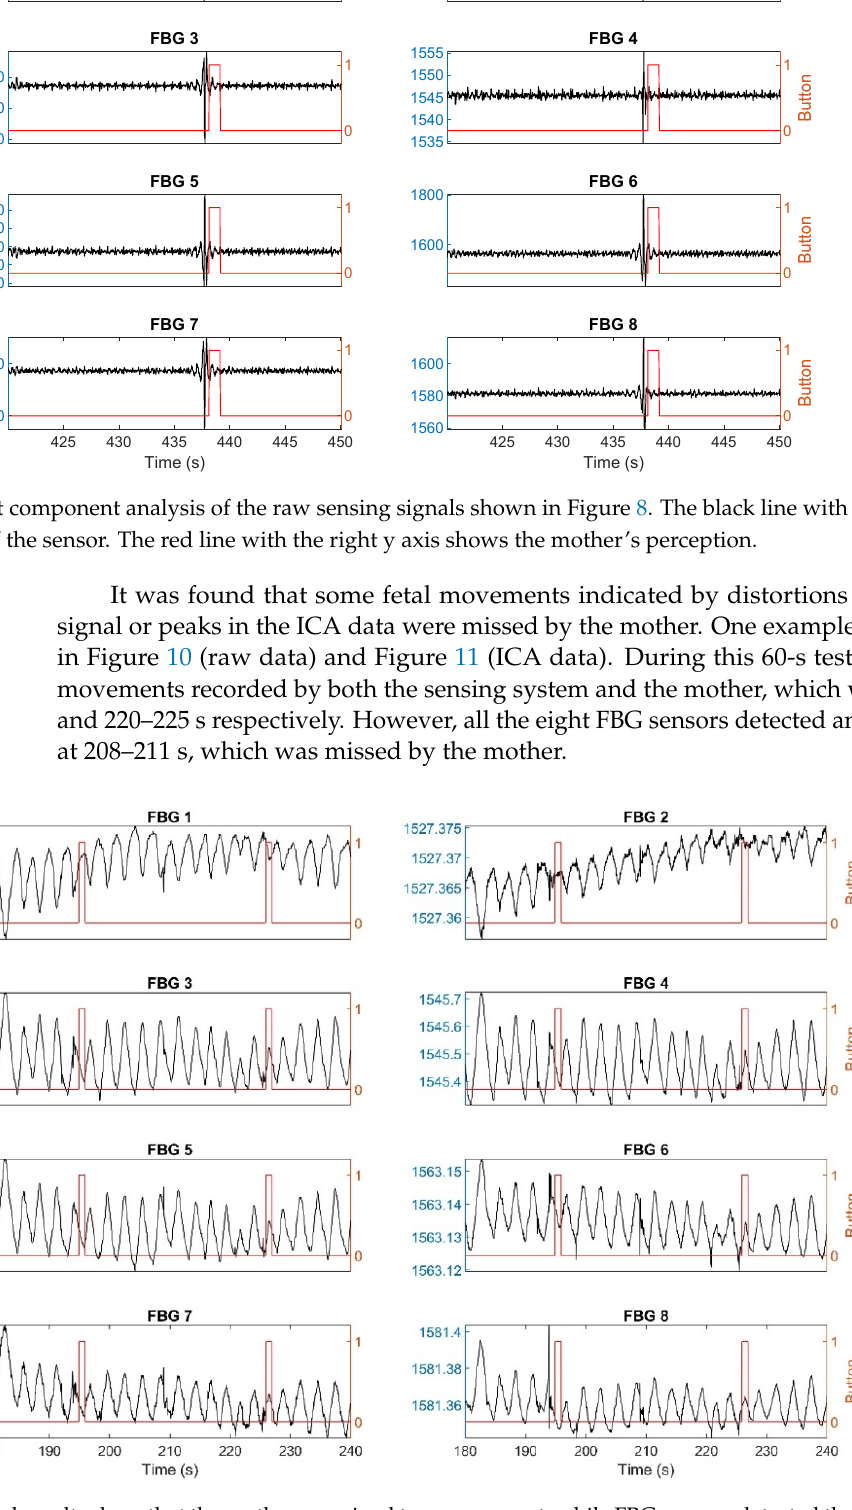
Figure 8. Experimental results for the eight FBG sensors for 30 s showing the breathing signals are distorted due to a fetal movement at 438 s. The black line with the left y axis shows the response of the sensor. The red line with the right y axis shows the mother’s perception.